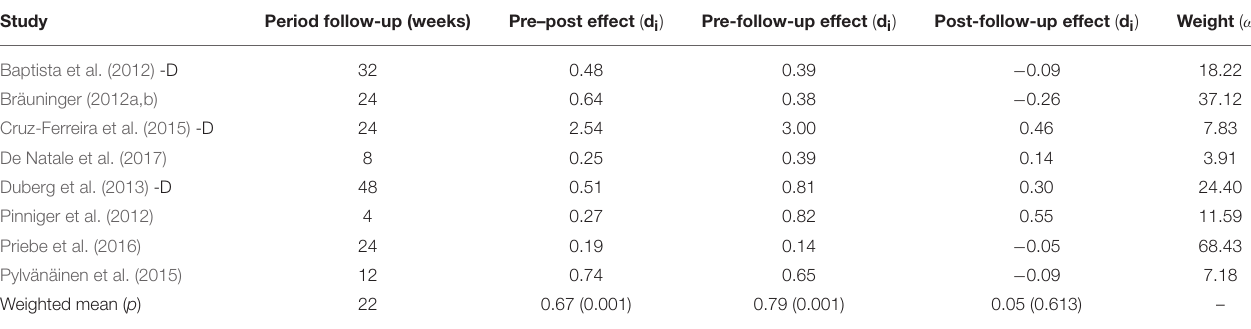
TABLE 8 | Effect sizes